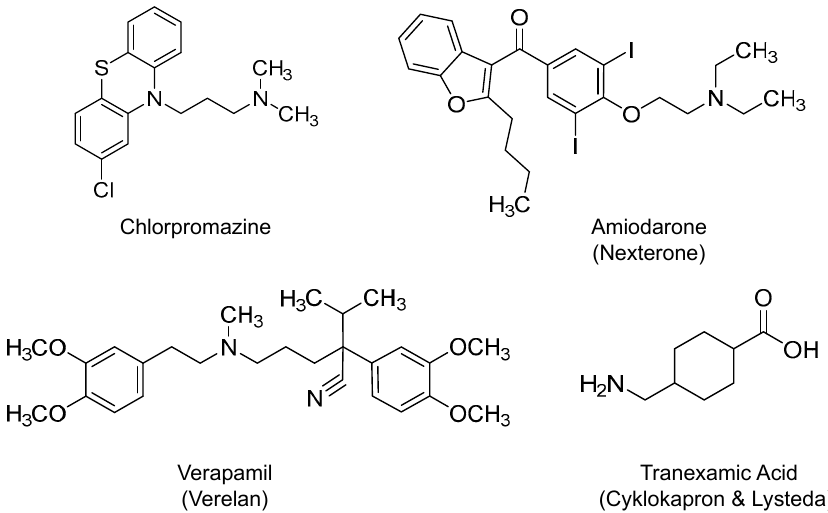
Figure 9. The chemical structures of alkylamine-based drugs that are currently being tested in COVID-19 patients. Presented are the antipsychotic phenothiazine chlorpromazine, the antiarrhythmic benzofuran-based amiodarone, the phenylalkylamine-based calcium channel blocker of verapamil, and the trans-stereoisomer of 4-(aminomethyl)cyclohexane-carboxylic acid antifibrinolytic agent, also known as tranexamic acid.